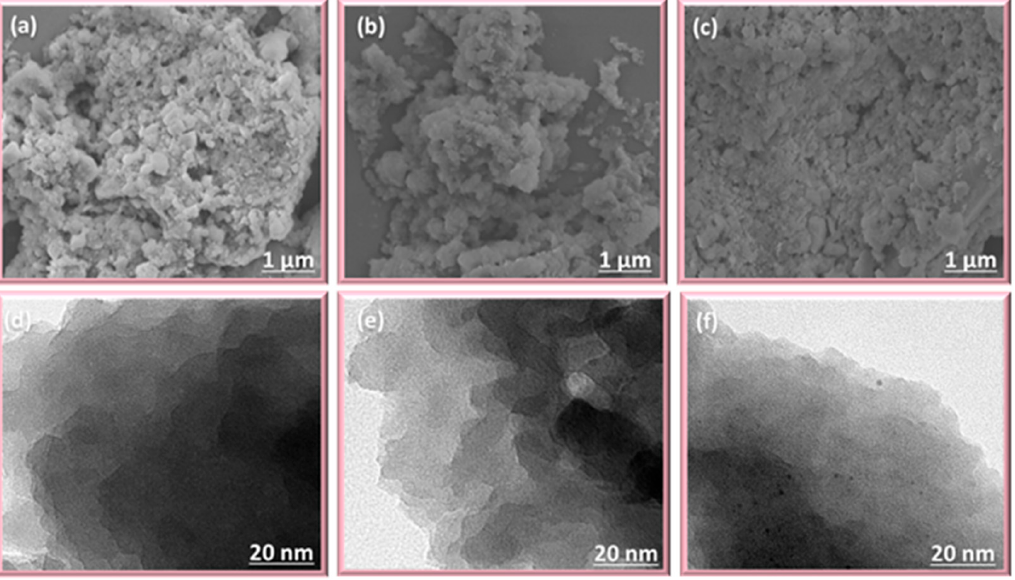
Figure 3. ( a – c ) SEM N 2 and ( d – f ) TEM images of PDAT-FC, TPA-FC, and TPE-FC CMPs,